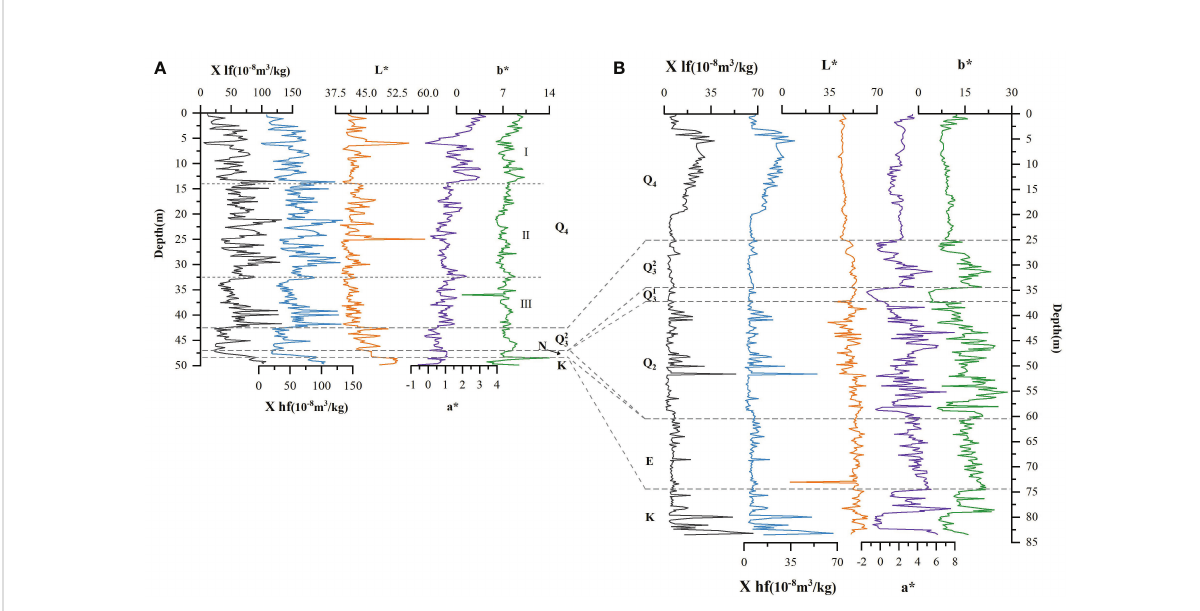
FIGURE 5 Low-frequency susceptibility (X lf ), luminance (L*), redness (a*) and yellowness (b*) curves of ZF (A) and FC (B) boreholes sediments.